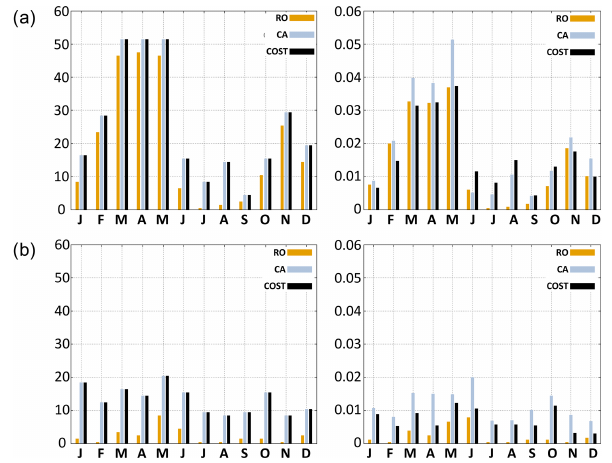
Figure 6. Annual cycle of the values in the series associated with RO, CA and COST. Panel (a) shows droughts, whereas (b) denotes extreme rainfall. The figures on the left represent the frequency (number of months with non-zero values) and those on the right de- pict normalised intensity. Intensity is normalised by dividing each datum by the maximum value of each